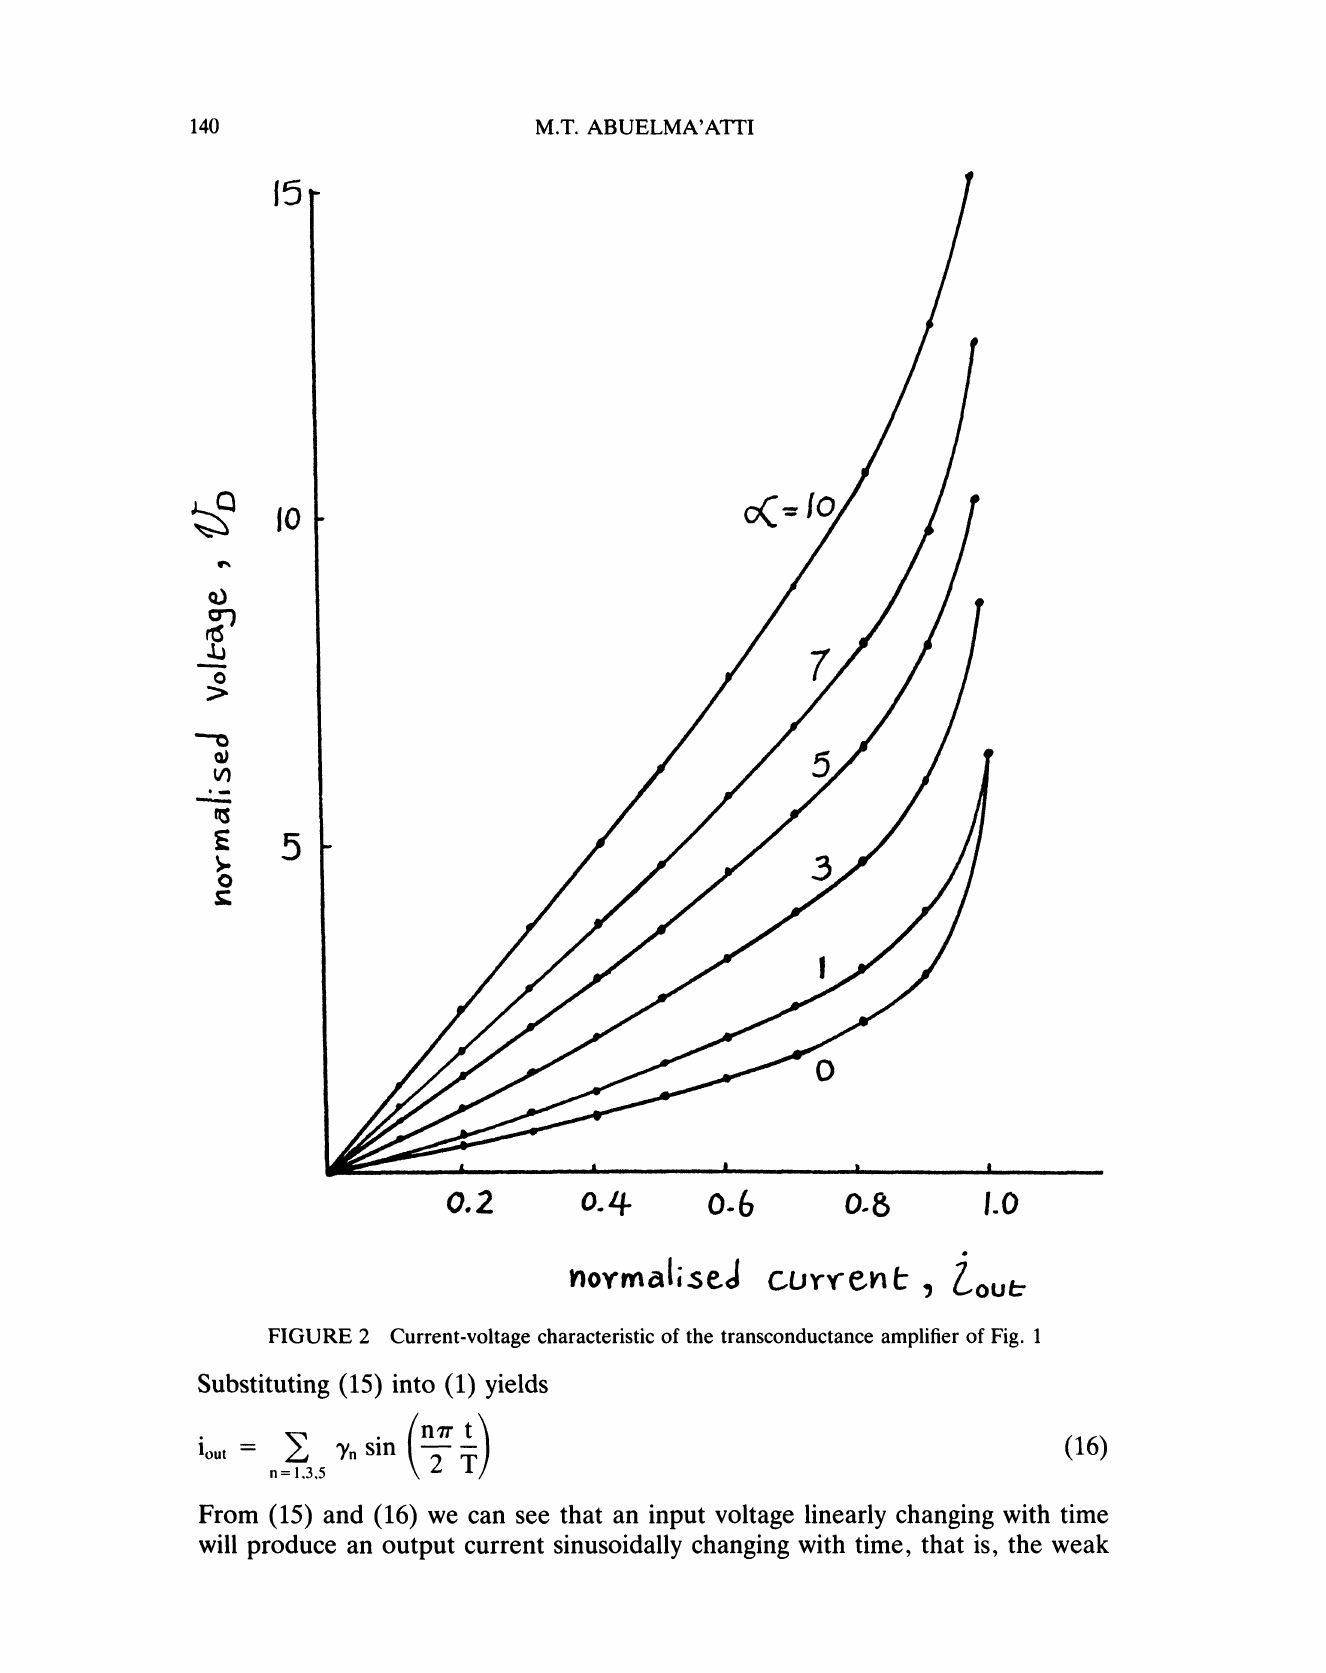
(16) lout E n sin